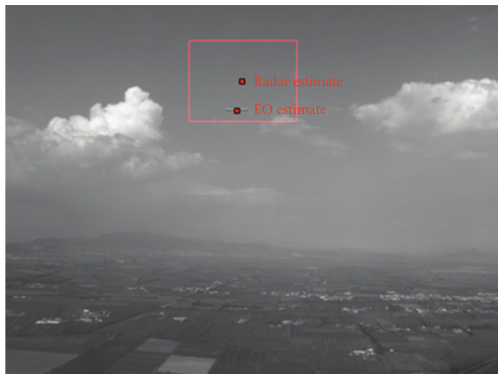
Figure 4: EO intruder position detection compared with radar- based tracker